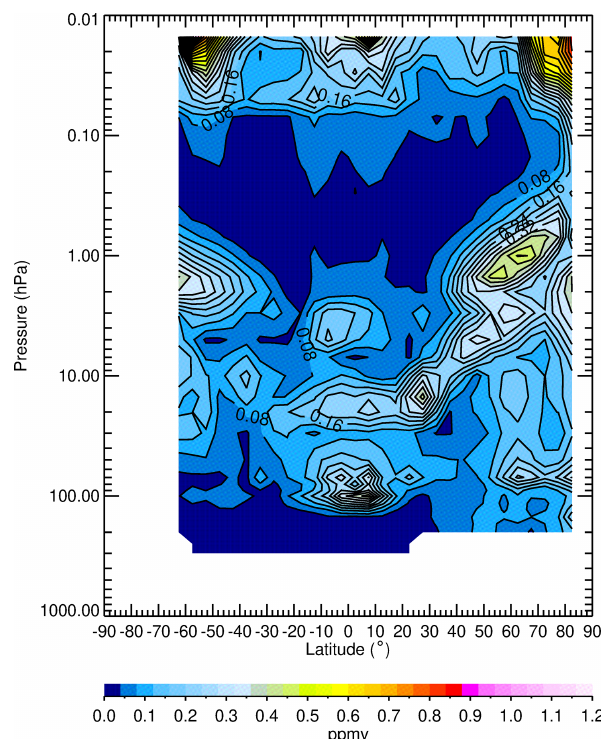
Figure 8. Average zonal (wave) standard deviation of ozone for March 1979. Contour interval is